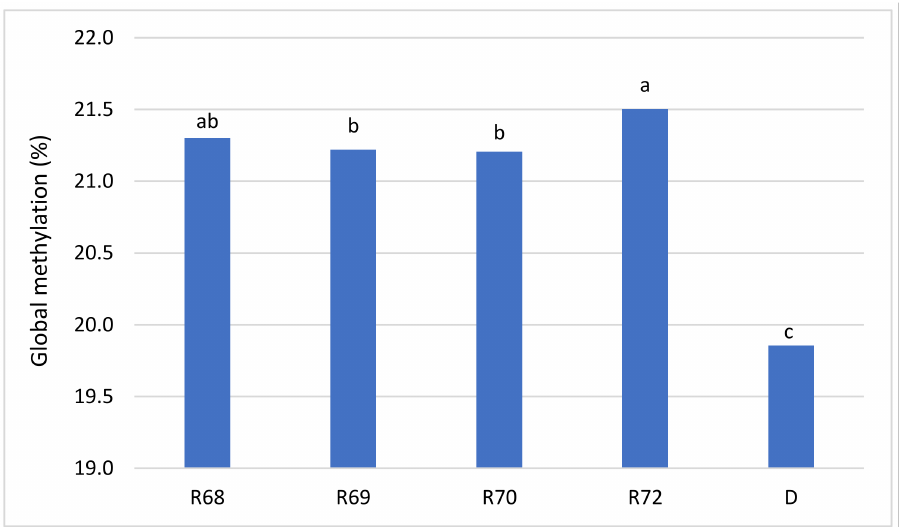
Figure 1. DNA methylation content (global methylation) based on RP-HPLC analyses. The a, b, c, Games–Howell post hoc test grouping. D-donor plants grouped together; R68–R72-regenerants obtained from successive donor